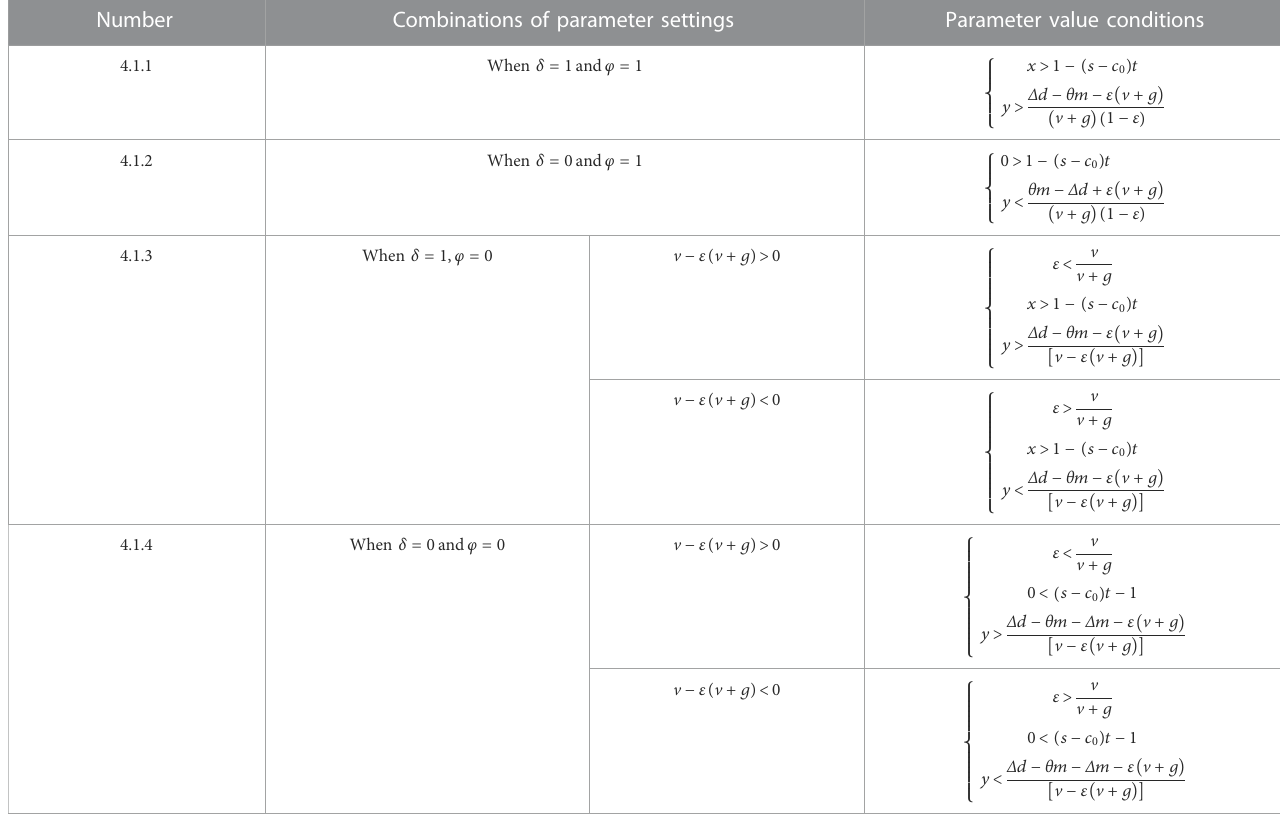
TABLE 6 Parameter value conditions in special cases. Number Combinations of parameter